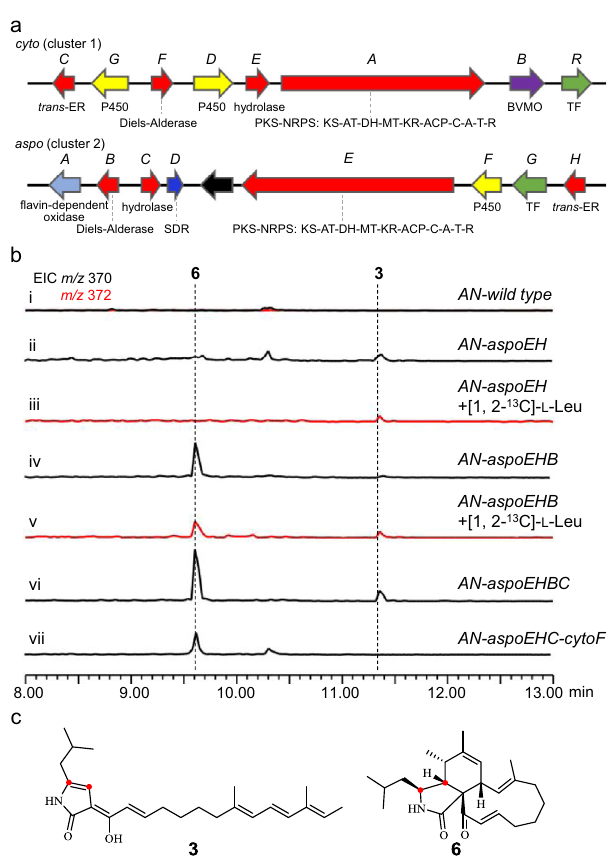
Fig. 2 Con fi rmation of the aspo cluster and the function of the four-gene conserved cassette. a Organization and proposed function of the cyto and aspo clusters in A. fl avipes KLA03. b LC-MS analyses of the culture extracts from the A. nidulans transformants. c Diagram showing the incorporation of [1,2- 13 C]- L -leucine into 3 and 6 . The extracted ion chromatograms (EICs) were extracted at m/z 370 [M + H] + for 3 and 6 , m/z 372 [M + H] + for 3 and 6 labelled with [1,2- 13 C]- L